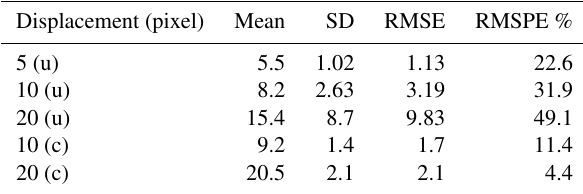
Table 1. Mean, standard deviation (SD), root mean square error (RMSE), and root mean square percent error (RMSPE) of cloud motion estimated from reconstructed images for constant displace- ments of 5, 10, and 20 pixels (u is uncorrected, c is corrected with a